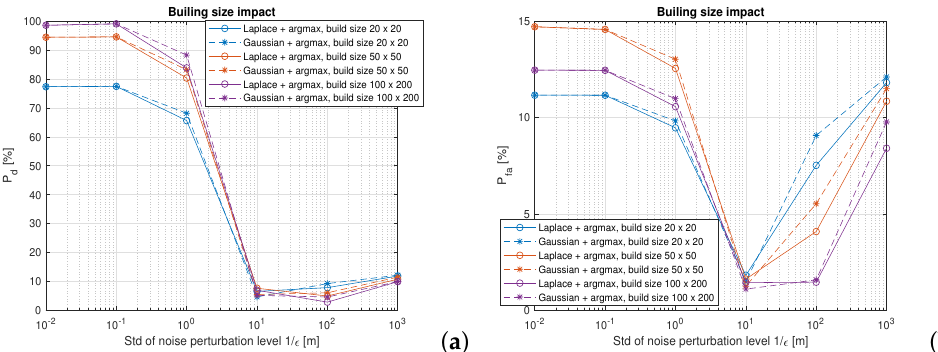
Figure 15. The impact of the building size on the application’s utility. A proximity service with γ = 2 m, fixed N u = 1000. ( a ) P d and ( b ) P fa